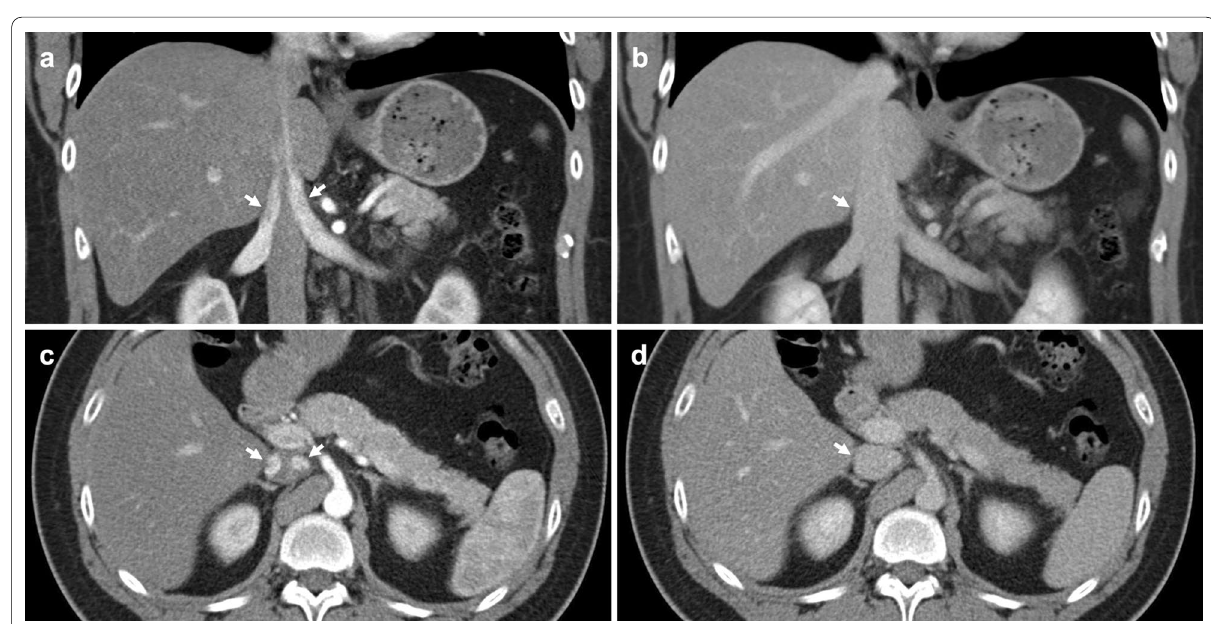
Fig. 23 IVC pseudothrombus due to mixing artefact. a,c Arterial phase CT demonstrates an apparent filling defect in the IVC attributable to contrast-enhanced blood (arrows) draining from both renal veins and running alongside a column of non-enhanced blood from the lower extremities. b,d Coronal and axial CT images of the suprarenal IVC (arrows) show resolution of the filling defect in portal venous